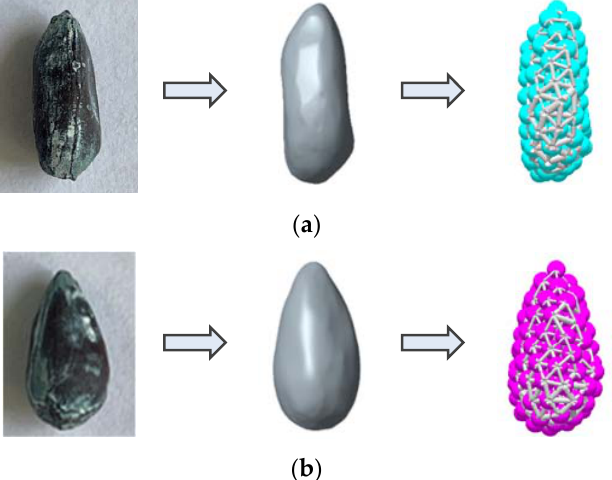
Figure 7. Discrete element simulation models of cotton seeds. ( a ) Flat cotton seed; ( b ) ellipsoidal cotton seed.